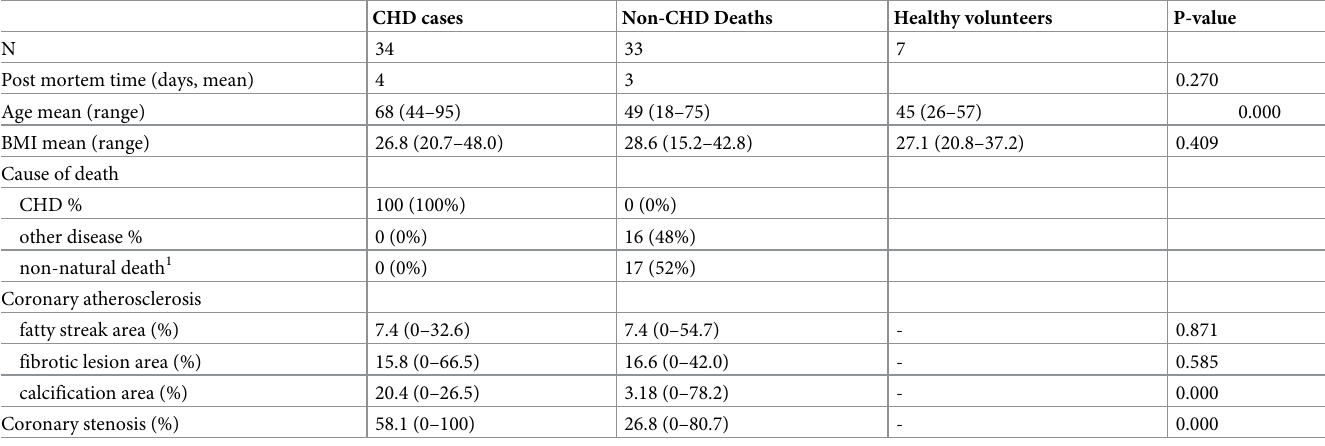
Table 1. Demographic characteristics of the study